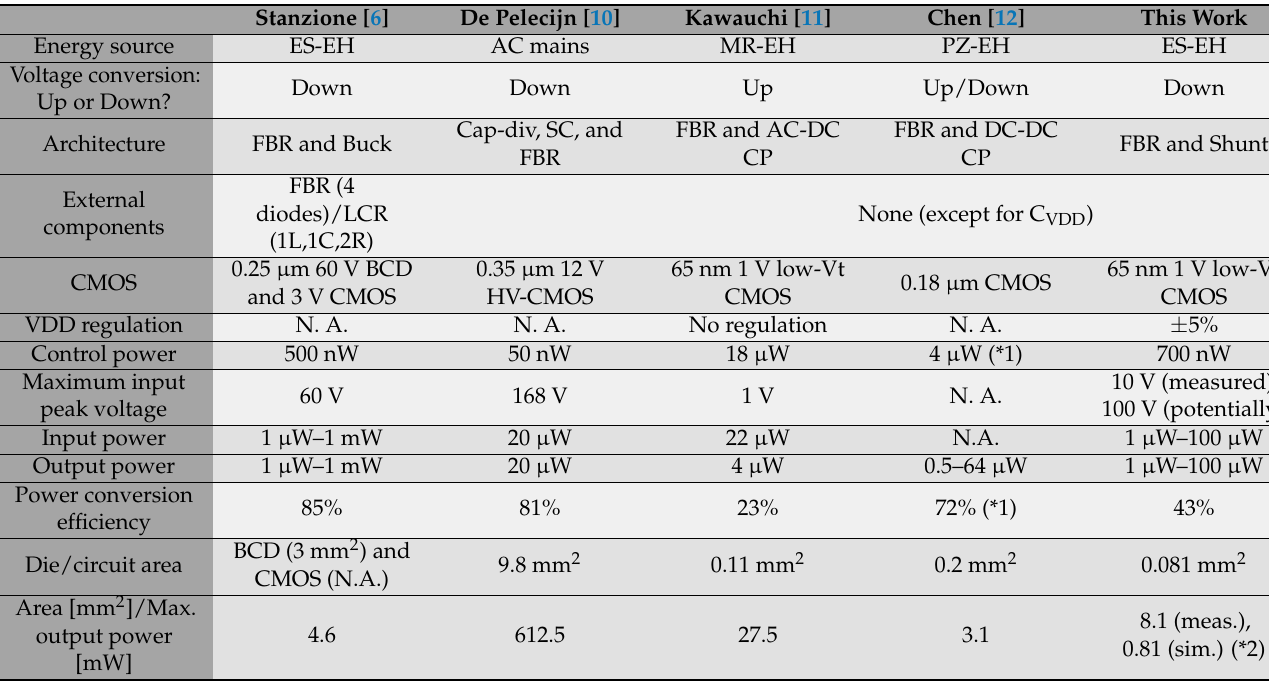
Table 3. Comparison table with previously reported converters.